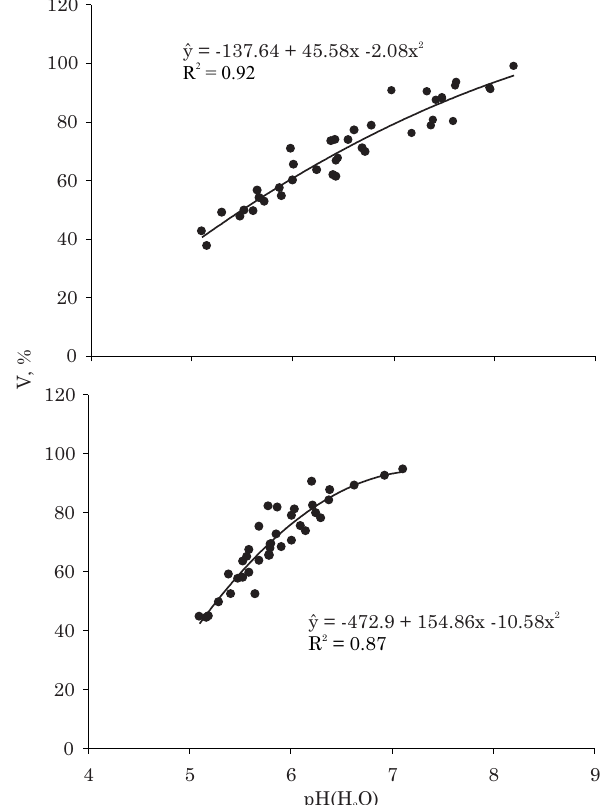
Figure 3. Relationship between base saturation (V) and soil pH(H 2 O) (1:1) in the 0.00-0.10 m layer 15 days after application (daa) and 210 daa of rice husk ash in 10 dosages, evaluated in four Table 3. pH values in the treatments absolute control (AC) and recommended fertilization and liming (RF) in samples from the layers 0.00-0.10 and 0.10-0.20 m, 15 days after application (daa) and 210 daa after application of rice husk ash. Averages of the three limed blocks